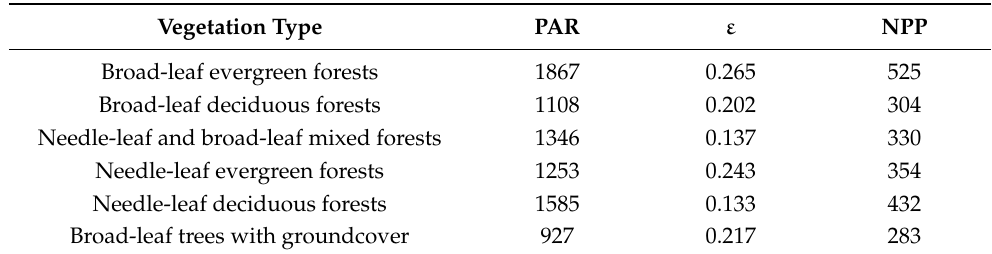
Table 3. Annual APAR (MJ · m − 2 a − 1 ) and annual average of typical forest vegetation types in